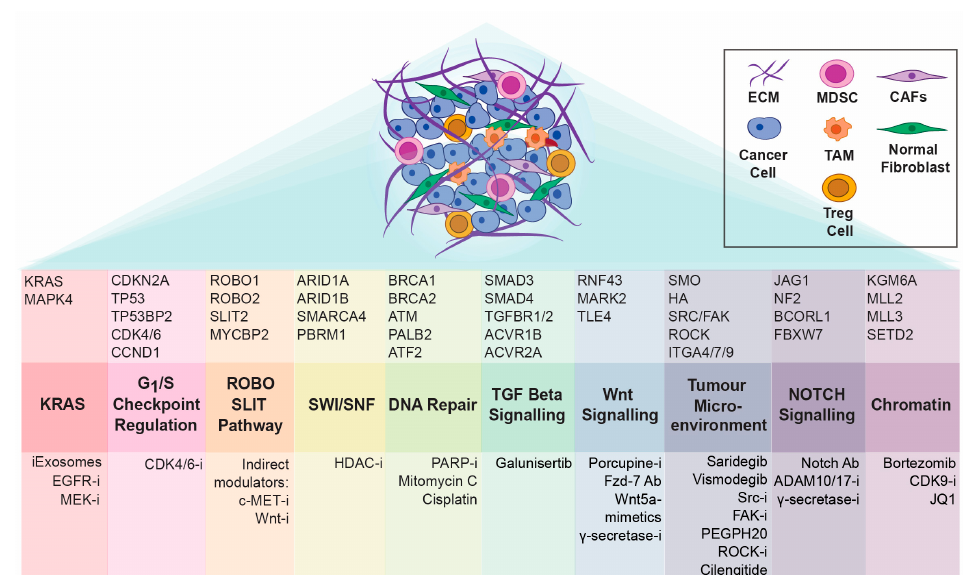
Figure 1. Frequently altered signalling pathways that drive pancreatic cancer progression, adapted and modified based on [4,37]. Key aberrations of interest, and associated targeted therapies in pre-clinical/clinical development, including small molecule inhibitors (i), antibodies (Ab) and other agents of interest are depicted. ECM: extracellular matrix; TAM: tumour-associated macrophage; MDSC: myeloid-derived suppressor cell; T-reg: regulatory T cell; CAF: cancer-associated fibroblast.